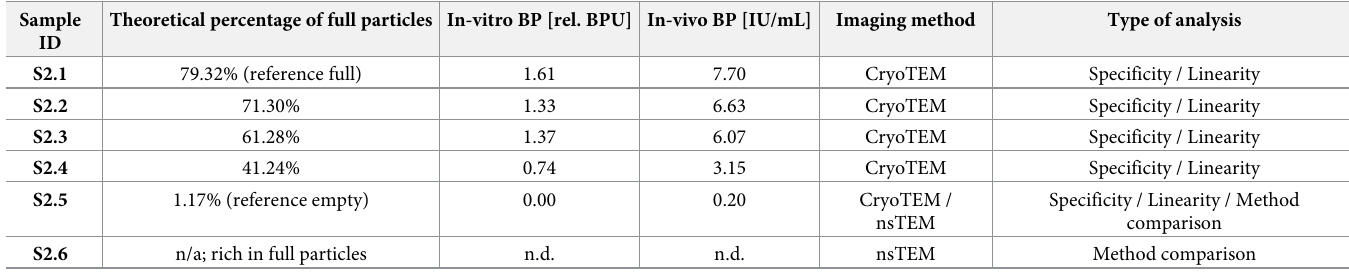
Table 3. Samples used for the specificity, linearity and comparative studies. Theoretical value calculations are described in section 4 of the Supplementary information. Sample